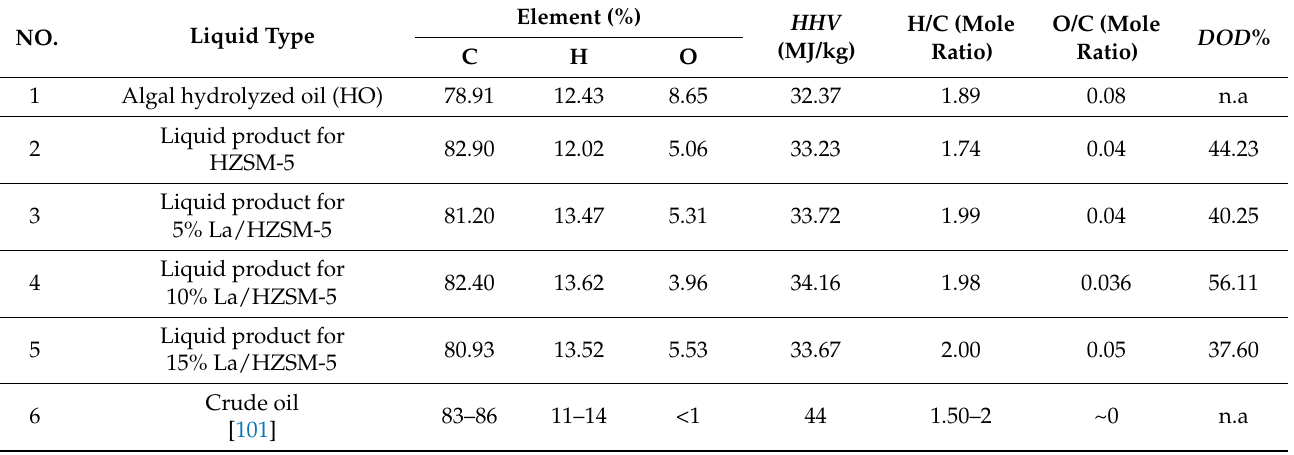
Table 7. The degree of deoxygenation, elemental composition, higher heating values, H/C, and O/C atomic ratios for the algal HO, and the liquid products of the catalytic deoxygenation over the parent HZSM-5 and lanthanum-modified zeolite catalysts.